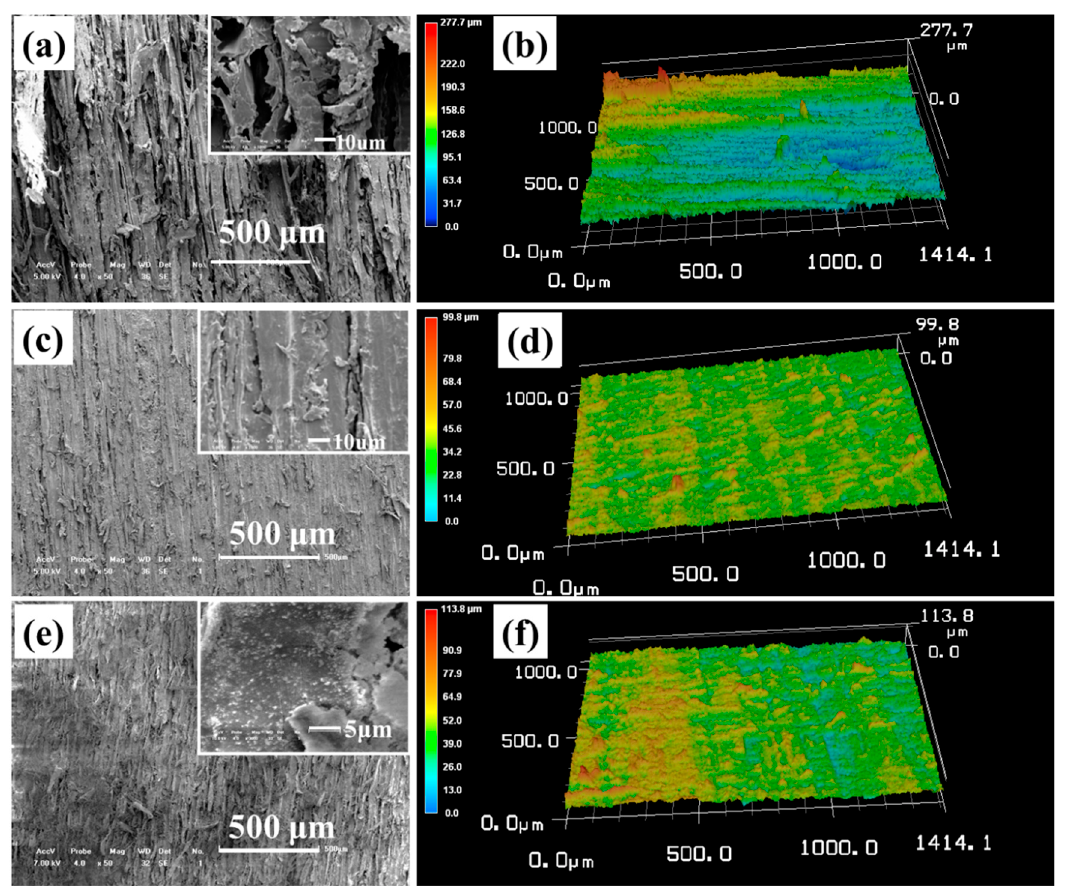
Figure 1. ( a ) Scanning electronic microscopy (SEM) and ( b ) 3D optical laser microscope system (OPM) images of raw wood. ( c ) SEM and ( d ) 3D OPM images of sanded wood. The insets are magnified SEM images with scale bars at 10 µ m. ( e ) SEM and ( f ) 3D OPM image of sanded wood coated with KH1322 fluoroalkylsilane and